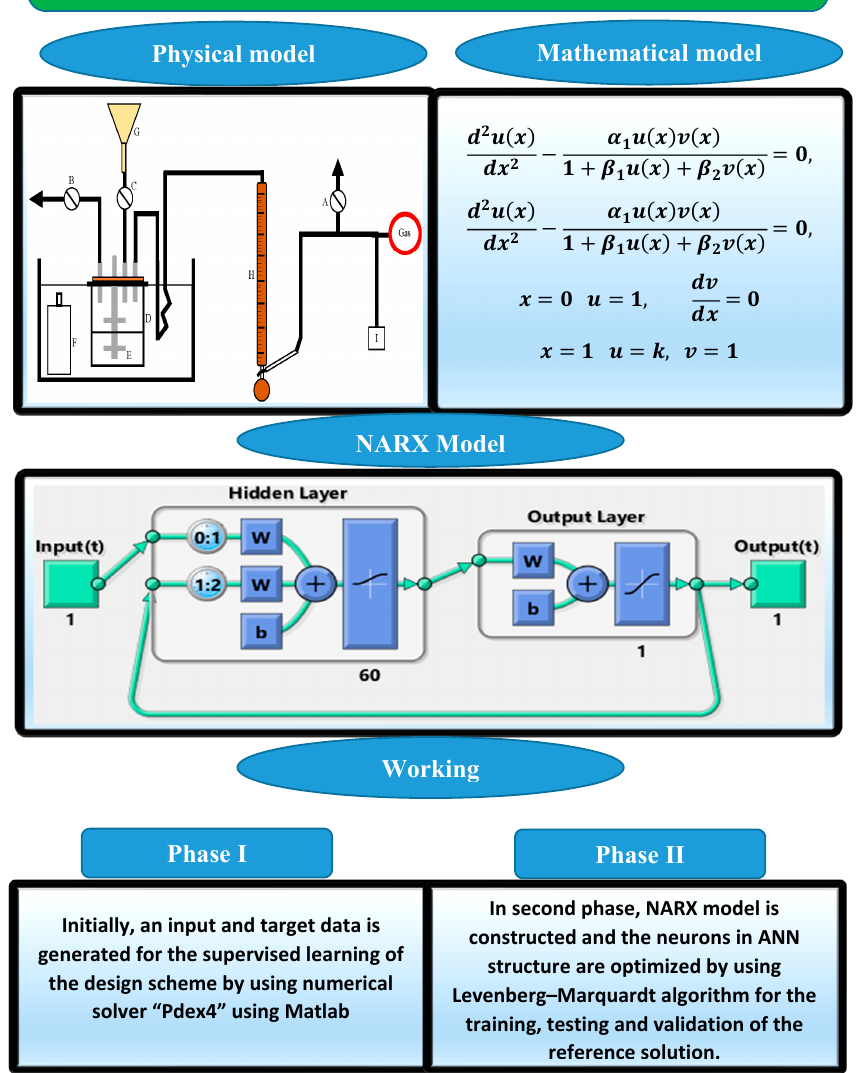
Figure 5. Mathematical model of the problem, NARX model, and workflow of the design